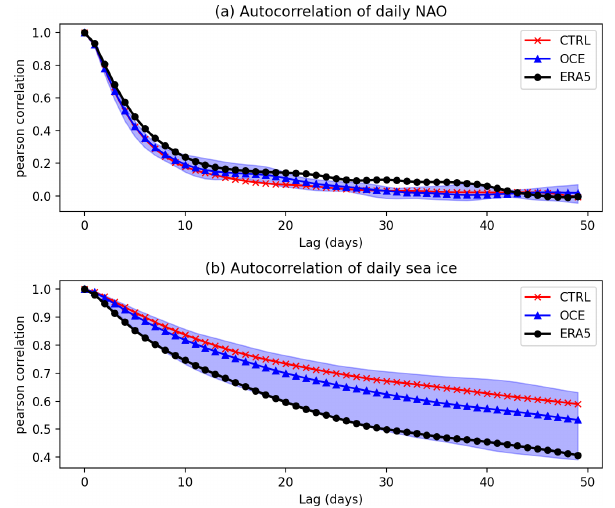
Figure 7. Autocorrelation of (a) the daily NAO and (b) the daily BKS sea ice for ERA5 (black dots), CTRL (red crosses), and OCE (blue triangles). Data are restricted to days in November through February, 1980–2015. Shading indicates the ensemble spread of OCE: the CTRL spread (not shown) is similar in extent.